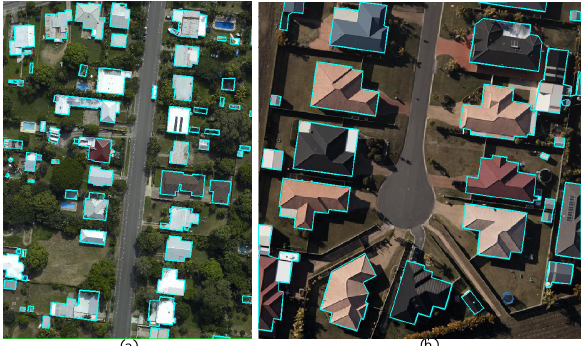
Figure 7. Data sets with reference boundary: (a) Aitkenvale, (b) Hervey Bay